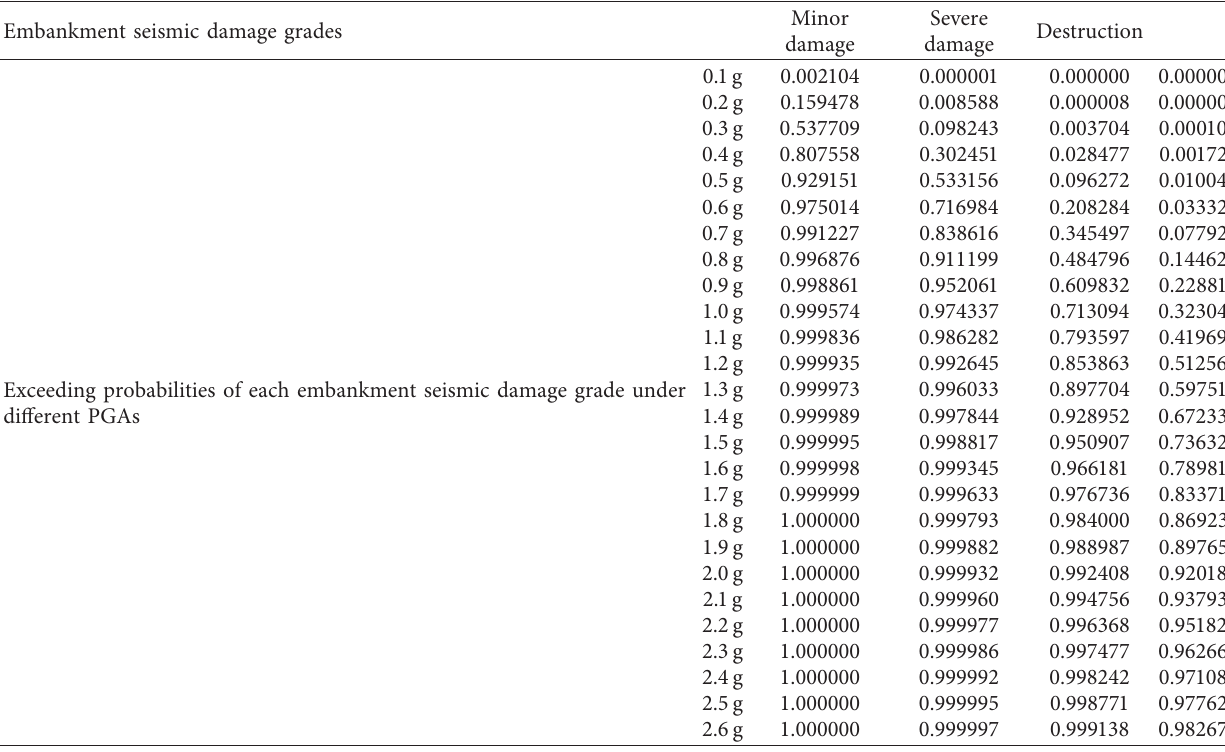
Minor Severe Destruction damage damage